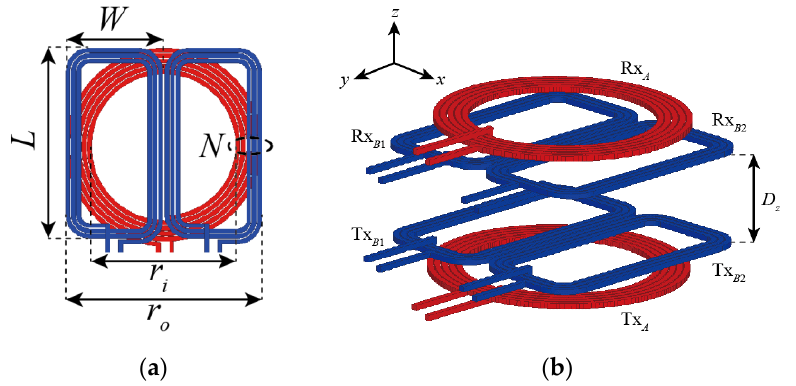
Figure 1. Configuration of: ( a ) 2 × 1 multilayer coil; ( b ) symmetric wireless power transfer (WPT) coil system based on proposed multilayer coils.